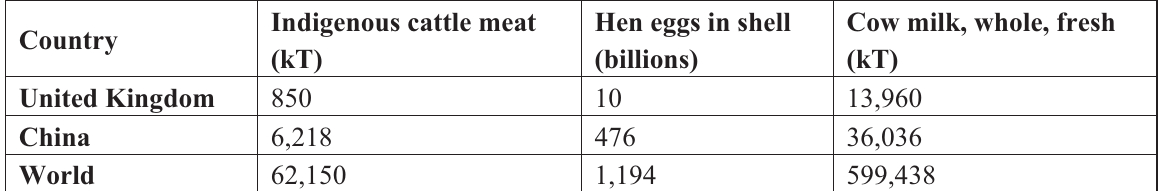
Table 1. Annual production of meat, eggs and milk in 2010 (source: FAO, [3]).